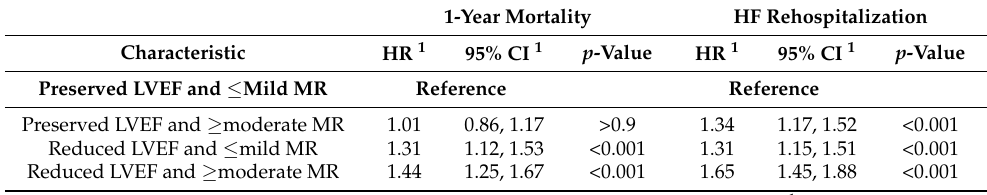
Table 3. Adjusted Cox regression analysis for 1-year all-cause mortality (Left) and 1-year year recurrent hospitalization (Right) according to LVEF and MR